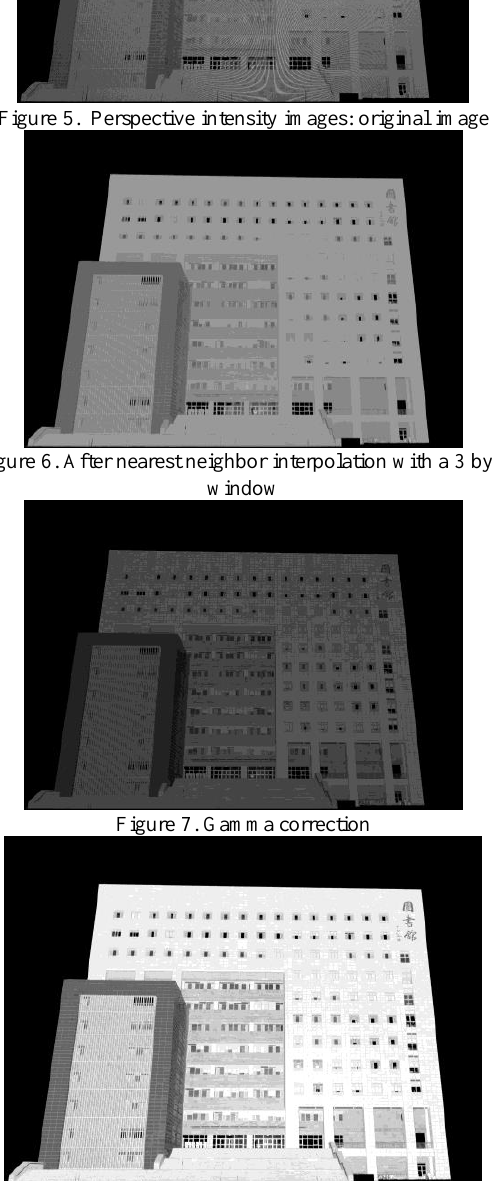
Figure 8. After greyscale